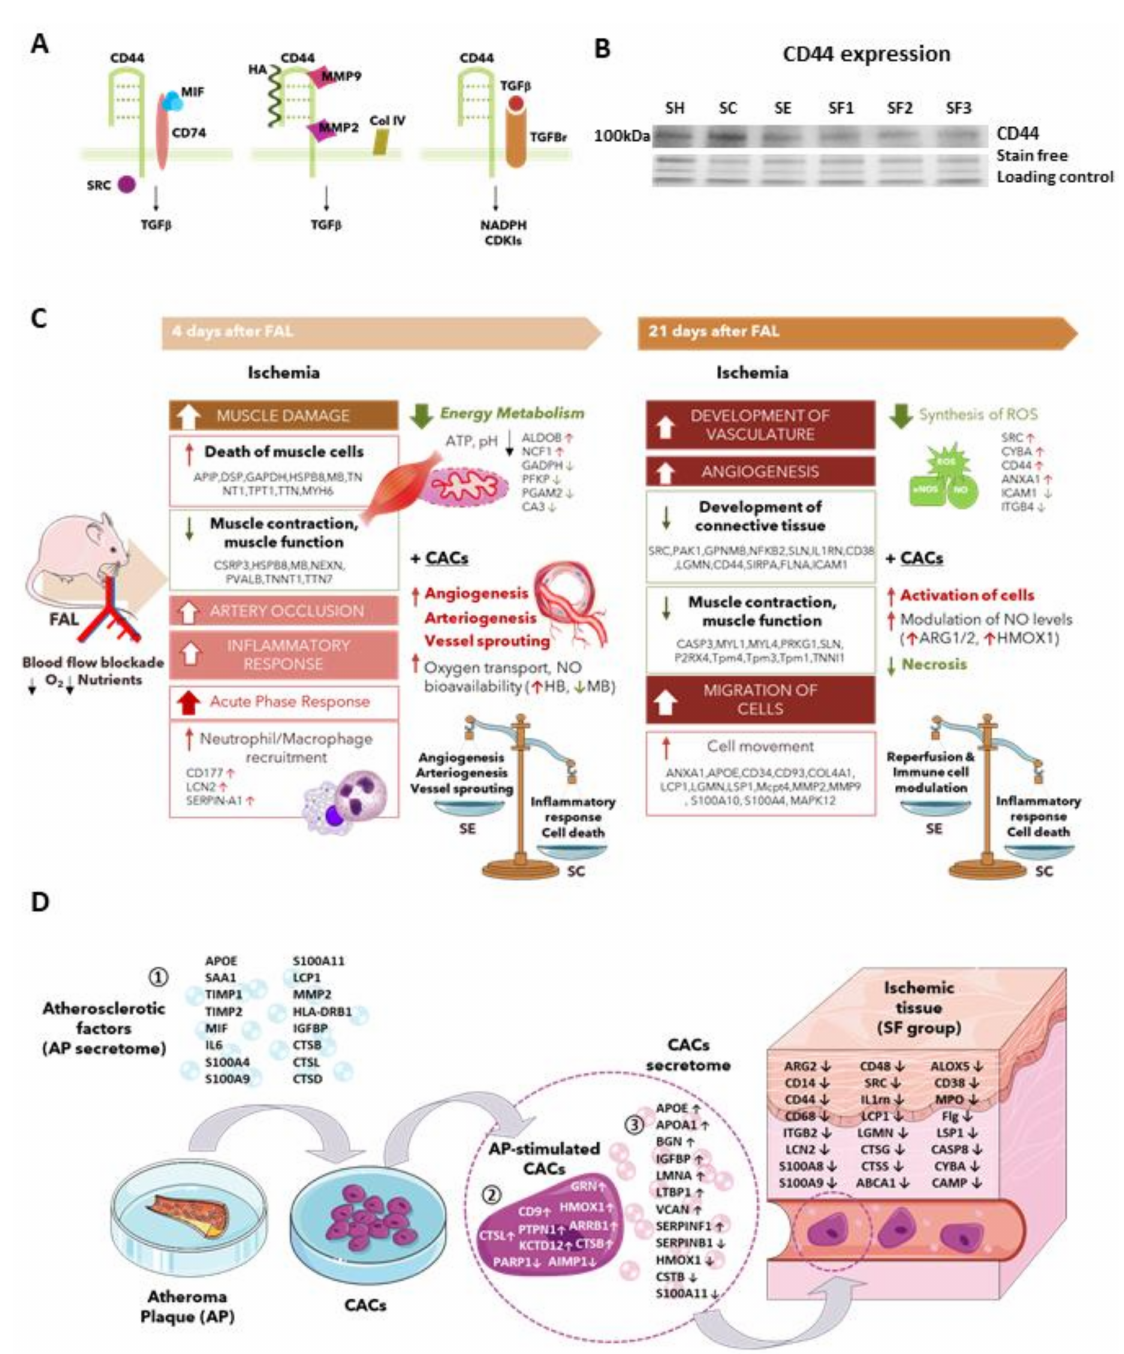
Figure 5. Potential mechanisms altered after ischemia and CACs therapy. ( A ) CD44 interactions with other proteins identified, based on literature searches. ( B ) Up-regulation of CD44 in SC mice was confirmed by WB. ( C ) Early and late molecular response of CLI mice with and without CACs treatment ( D ) Proteins involved in pre-stimulation of CACs process. Atherosclerotic plaques (AP) composition, ex vivo CACs response to an atherosclerotic environment, and in vivo modifications after pre-stimulated CACs administration over CLI mice. 1 (cid:13) Duran et al., 2003 [63]; 2 (cid:13) Vega et al., 2017